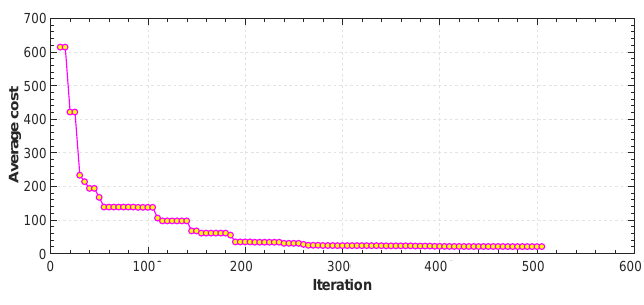
Figure 11. Average cost function vs. iteration for FL.